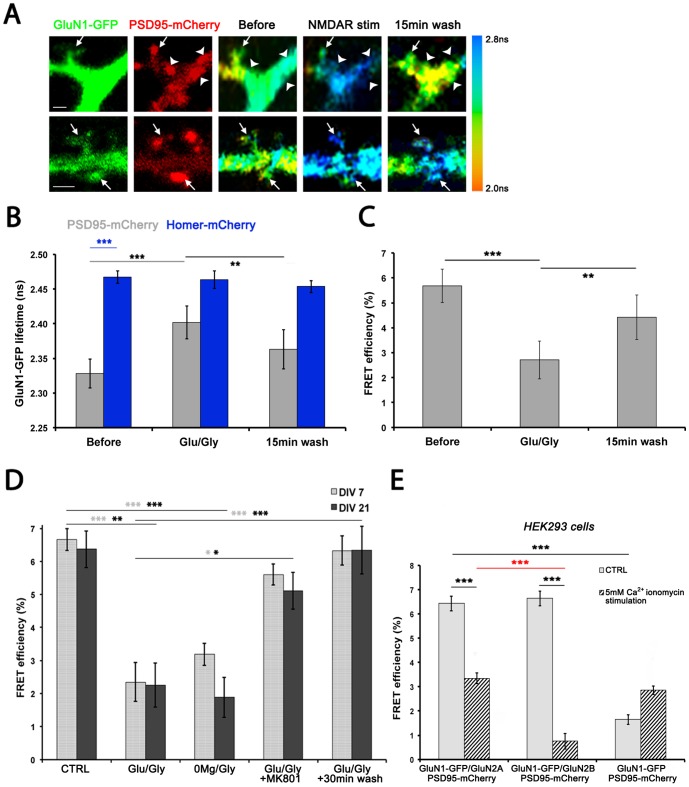
The interaction between PSD95 and the NMDAR is transiently disrupted upon NMDAR stimulation.(A) Two examples of confocal images of 14 DIV dendrites expressing GluN1-GFP (first column) and PSD95-mCherry (second column). Next are shown corresponding FLIM images of the same dendrites before (third column), just after stimulation (fourth column) and 15 min after washing out the stimulation solution (last column). The arrows point to spines in which the lifetime increased upon stimulation, the arrowheads point to dendritic shaft synapses in which the lifetime is also increased by stimulation. Color-coding represents GluN1-GFP lifetime from 2 ns to 2.8 ns (columns 3 and 4). Scale bar is 1 µm. (B) GluN1-GFP lifetime in PSD95-mCherry clusters increases upon 1–2 min Glu/Gly stimulation and decreases after 15 min wash (gray, 16 live neurons). Repeated measures ANOVA was performed (p<0.0001), followed by Bonferroni post hoc test. ** indicates p <0.01 and ***  =  p<0.001 through the figure. GluN1-GFP lifetime is significantly higher in Homer-mCherry clusters than in PSD95-mCherry clusters (dark blue, 15 live neurons). One-way ANOVA test with 6 groups was performed (p<0.0001), followed by Bonferroni post hoc test. Before stimulation and 15 min after, PSD95-mCherry neurons are statistically different from Homer-mCherry neurons (p<0.001 and p<0.01 respectively). Glu/Gly stimulation and washing had no effect on GluN1-GFP lifetime in Homer-mCherry clusters (Repeated measures ANOVA test was not significant). (C) FRET efficiency in GluN1-GFP/PSD95-mCherry expressing cells (same neurons as in B, calculated with GluN1-GFP/Homer-mCherry as the donor lifetime (experiments done the same day)) decreases upon 1–2 min Glu/Gly stimulation and increases again after 15 min wash. Repeated measures ANOVA was performed (p<0.0001), followed by Bonferroni post hoc test. (D) In DIV7 (light gray) and DIV21 (dark gray) neurons, FRET efficiency decreases after 1–2 min Glu/Gly stimulation and 5 min 0Mg2+/Gly stimulation. Neurons were fixed and mounted prior to imaging (see Methods). After 30 min of wash in High Mg2+ solution, FRET is back to basal levels. MK-801 blocks the FRET loss. Each bar in the histogram is the mean FRET efficiency of at least 10 neurons (one mean value/neuron obtained from ≈40–200 synapses), taken from at least 3 separate animal preparations. Kruskal-Wallis test was performed on both DIV7 and DIV21 groups p<0.0001 for both ages. Dunn's test was used for post hoc comparison. (E) The interaction between the NMDAR and PSD95 is mediated via an interaction with GluN2A or GluN2B and is dissociated by Ca2+ influx in HEK293 cells. The cells were co-transfected with the indicated constructs and treated as described in the methods. To confirm the differences between groups, Kruskal-Wallis test was performed (p<0.0001), followed by Dunn's post hoc test.